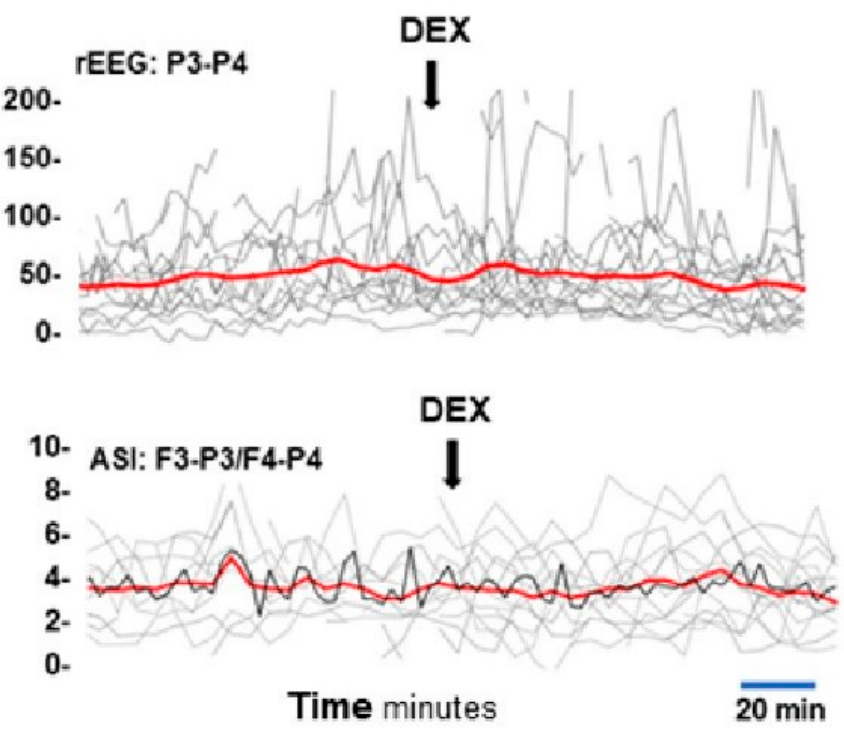
Figure 4. Time trend of rEEG and ASI . Time trend for rEEG from channel P3-P4, and ASI from channel F3-P3/F4-P4. Grey lines show the individual mean values, and the red line shows the mean values of the whole cohort during 2.5 min epochs.